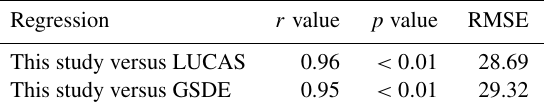
Table 5. This table shows the results of the linear regression be- tween the simulated total SOC stocks (TgCyr − 1 ) and those of the Global Soil Dataset for Earth system modeling (GSDE) and from the LUCAS database. The regression is done after aggregating the data at subbasin level for the 13 subbasins that were delineated into the Rhine catchment. RMSE is the root mean square error given in TgCyr − 1 , while the r value is the spatial correlation coefficient.